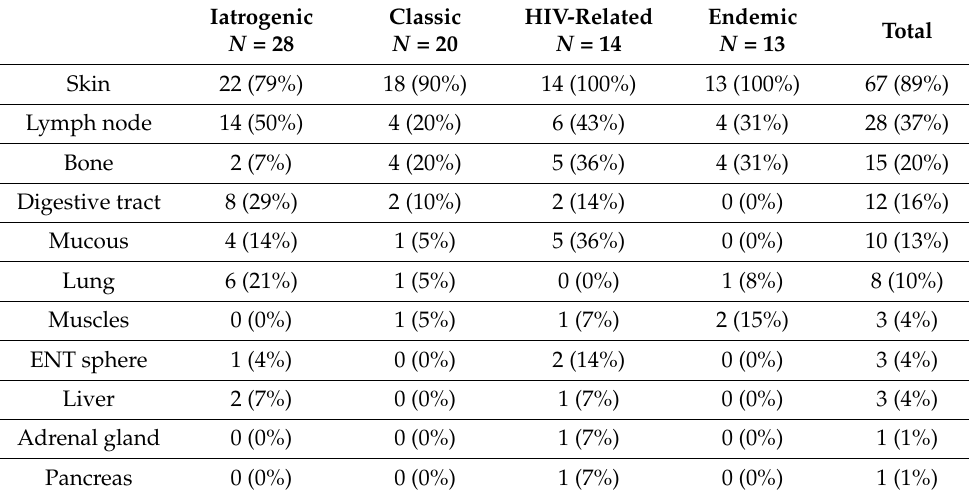
ENT: ear, nose, and throat.